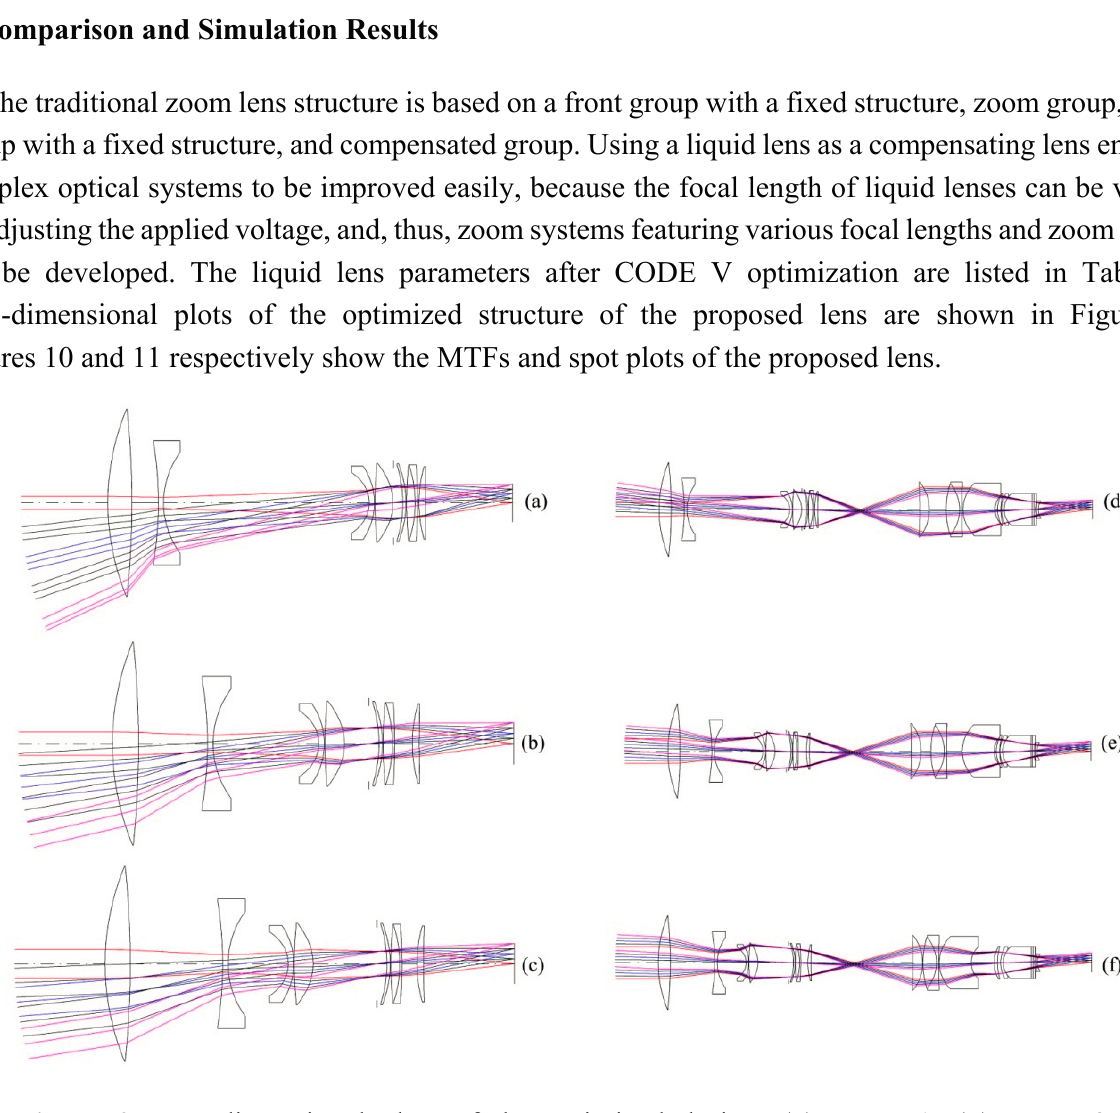
Figure 9. Two-dimensional plots of the optimized design: ( a ) Zoom 1; ( b ) Zoom 2; ( c ) Zoom 3; ( d ) Zoom 4; ( e ) Zoom 5; ( f ) Zoom